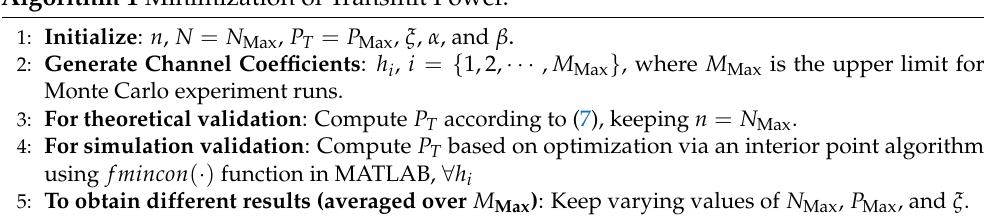
Algorithm 1 Minimization of Transmit